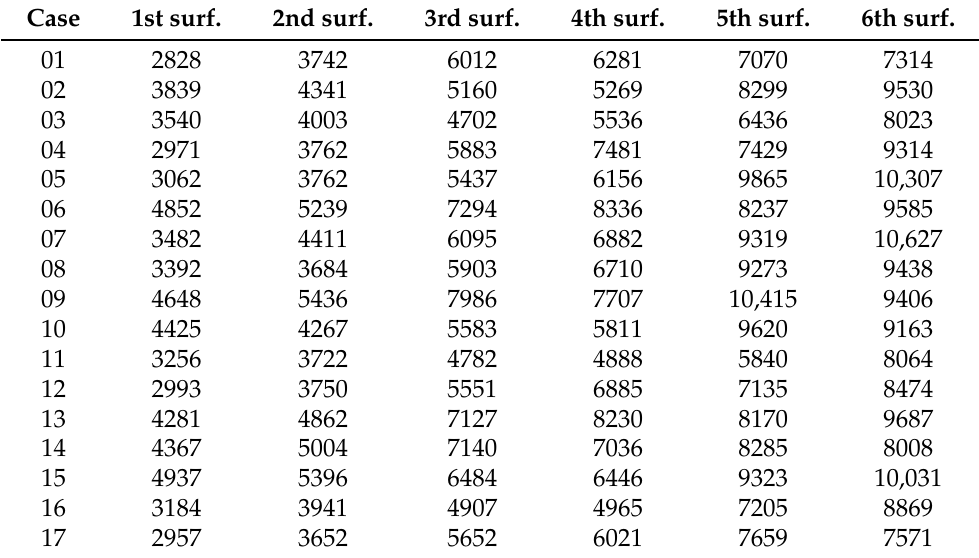
Figure 6. Persistence diagrams associated with the reference surface, PD k ( M 0 ) , for k = 0 ( left ), k = 1 ( center ) and k = 2 ( right ) Table 2. Multi-scale topological distance of the six deformed surfaces related to the six most signifi- cant deformation modes, of the 17 choices of the structure thickness with respect to the reference undeformed surface.